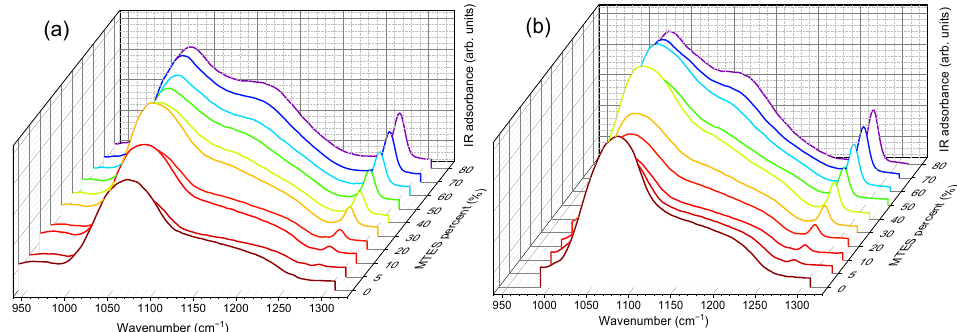
Figure 7. Magnification of the 950–1300 cm − 1 wavenumber region, for ( a ) series A and ( b ) series B, where the Si–O–Si asymmetric and δ s C–H vibrations are measured. The down shift of both maxima with the increase in the amount of –CH 3 can be observed(series A and series B labels represent the pH = 2.0 and pH = 4.5). A slight contribution of the H–O–H bending mode of water molecules at 1631 cm − 1 was observed (see Figure 6). It is worth mentioning the shift towards lower values exhib- ited by the 3000–4000 cm − 1 band, ascribed to the fundamental OH stretching vibration of different hydroxyl groups, suggesting an increasing hydrophobicity of the silica gels with an increasing methyl content. The band intensity decrease was the most pronounced in the case of the samples without methyl groups and with a low concentration of MTES. Accordingly, a reduction in the band intensity as the MTES amount increased is an exper- imental indication of the increased hydrophobicity of the investigated materials. The same tendency can be observed for the symmetric vibration of the Si-OH bond, evidentiated by a shoulder at approximatively 950 cm − 1 . The maximum was moving to lower values with the increasing concentration of the MTES (Figure 7). This shift was explained with the increasing distance between the silica planes with the increasing number of the methyl groups, which was attributed to the ratio modification of LO 4 -TO 4 vibrational modes ( ν as (Si–O–Si)TO at ~1075 cm − 1 and ν as (Si–O– Si)LO at ~1180 cm − 1 ) and caused a decrease in porosity or an increase in the system density, as expected, in agreement with the SAS data, electron microscopy and DFT modelling of low-temperature nitrogen porosimetry data.